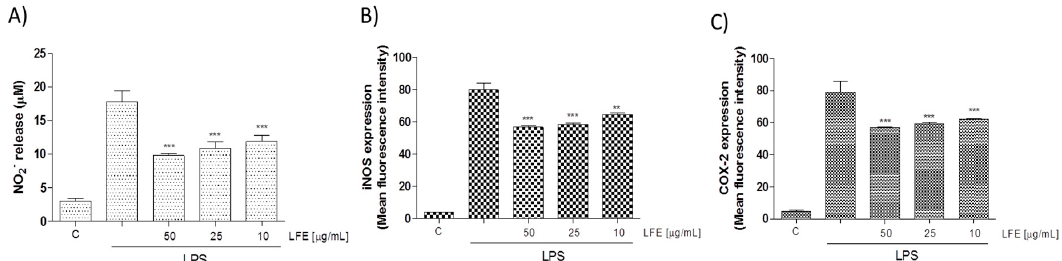
Figure 2. Effect of Lempso flavonoidic extract (LFE) (10–50 µ g mL − 1 ) on nitric oxide (NO) release, evaluated as NO 2 − ( µ M), by macrophages J774A.1 stimulated with lipopolysaccharide from E. coli (LPS) (Panel A). Effect of LFE (10–50 µ g mL − 1 ) on LPS-induced inducible nitric oxide synthase (iNOS) (Panel B) and cycloxygenase-2 (COX-2) (Panel C) in macrophages J774A.1. Values are expressed as mean ± s.e.m of at least three experiments, each in triplicate. Comparisons were performed using one-way analysis of variance and multiple comparisons were made by Bonferroni’s test. *** and ** denote p < 0.001 and p < 0.01 vs. LPS alone.